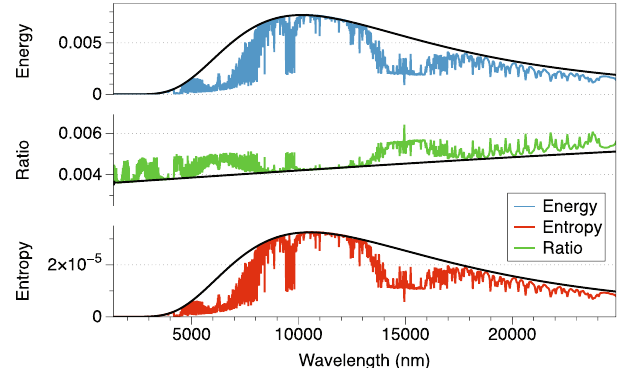
Figure 5. Energy (W/m 2 /nm), entropy (W/m 2 /nm/K) and ratio ( K − 1 ) of Earth’s upwelling radiation. The black solid line represents a blackbody at temperature T = 285